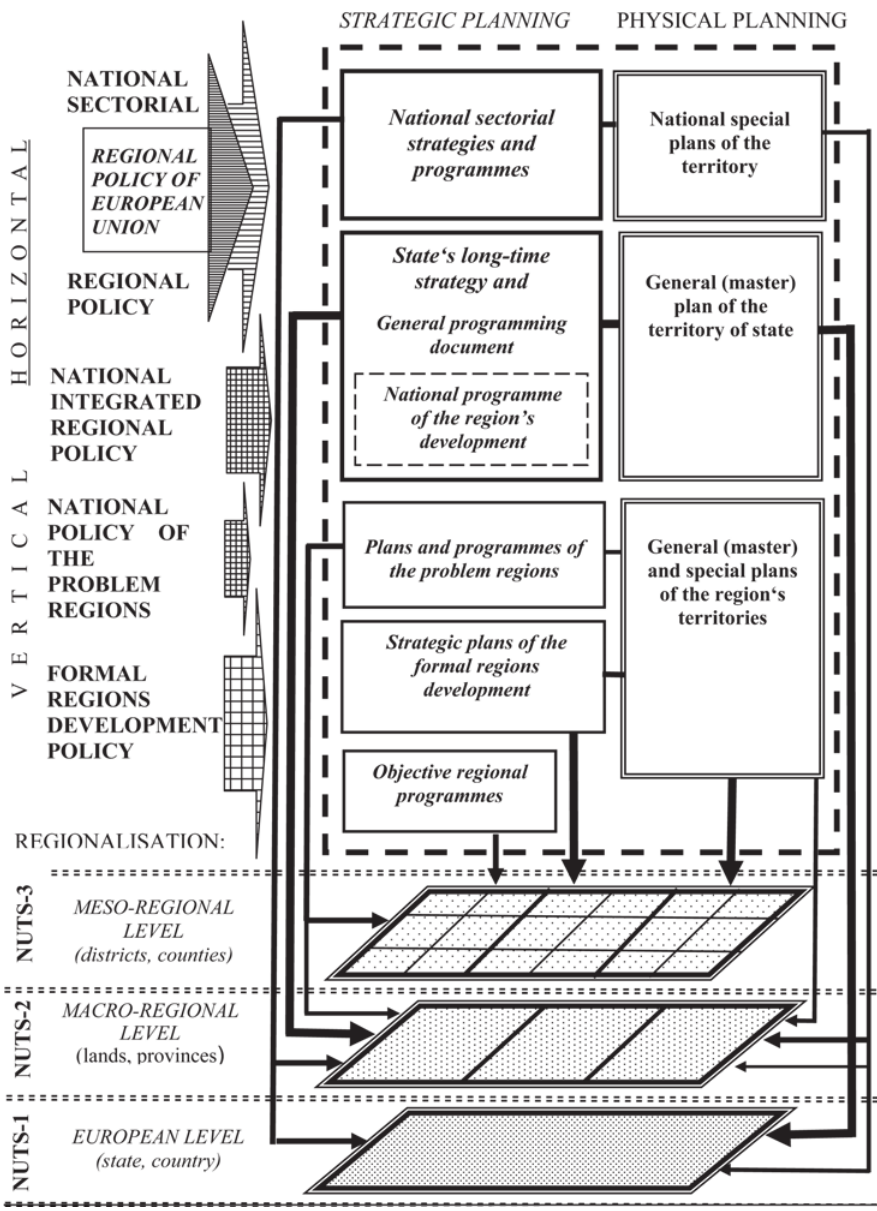
Fig. 2. The proposed model of the regional planning